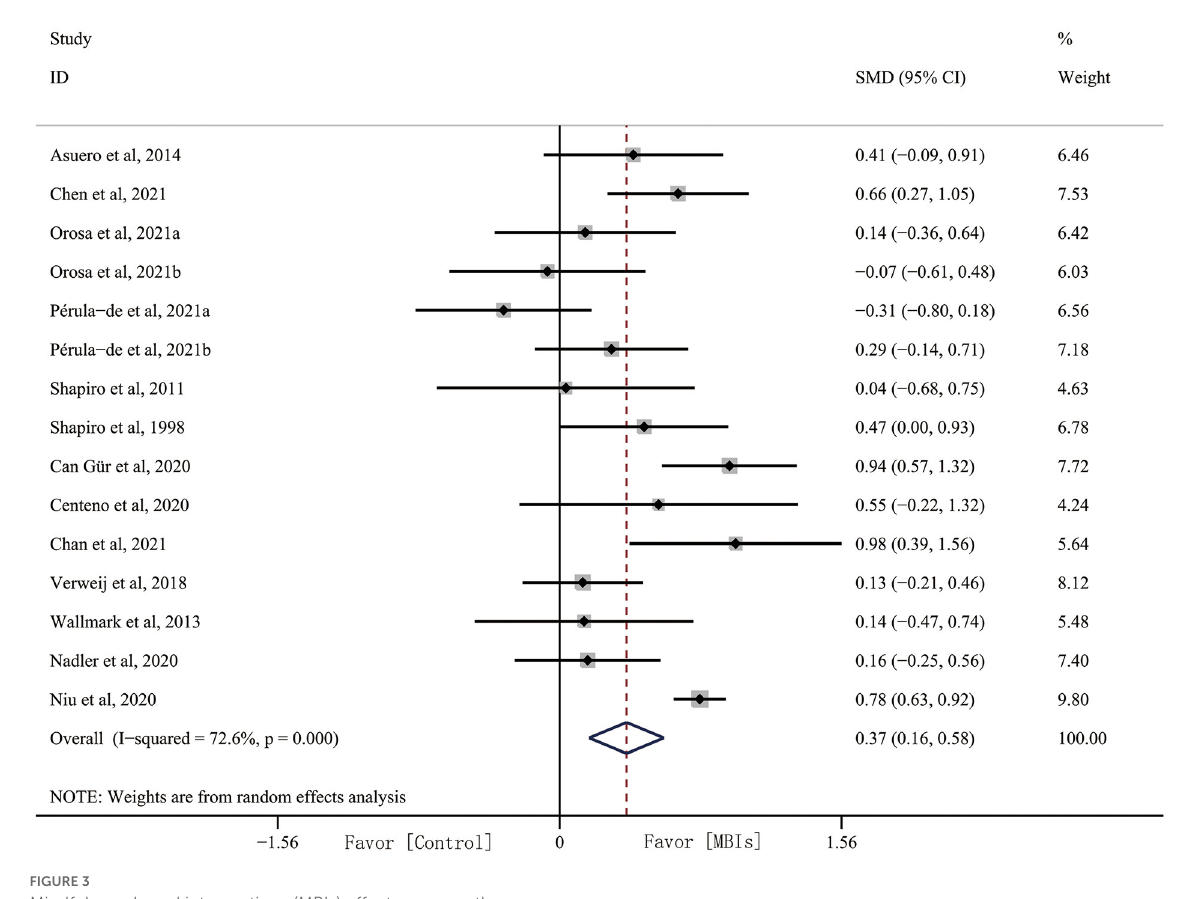
FIGURE3 Mindfulness-based interventions (MBIs) effects on